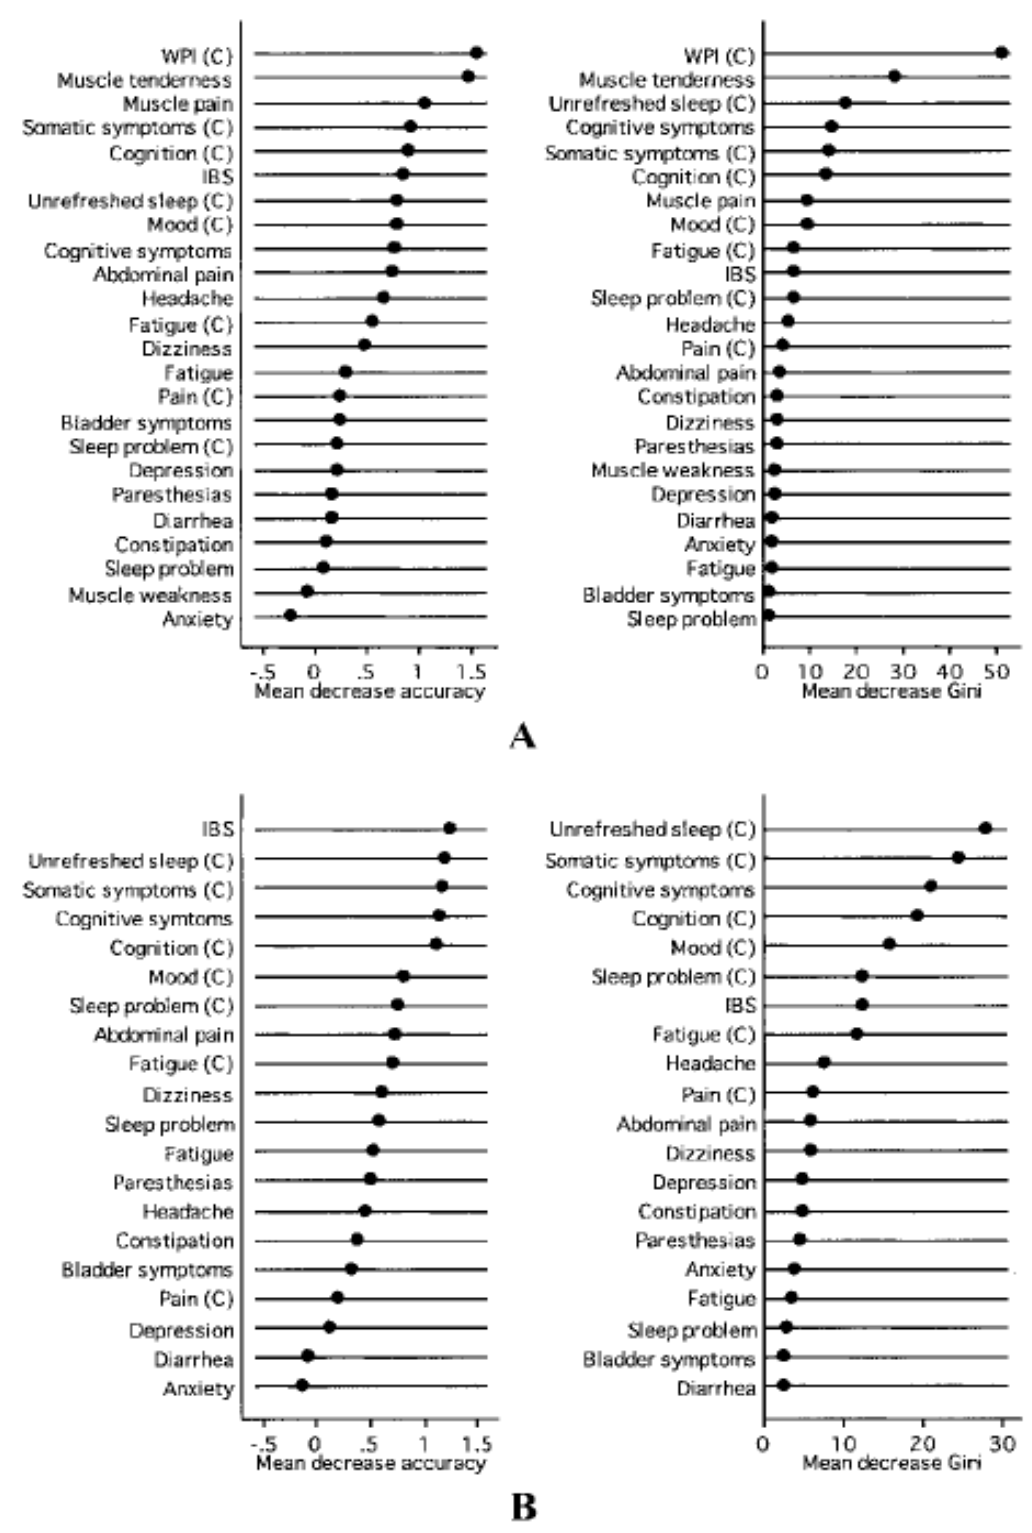
Figure 3. Symptoms of fibromyalgia according to the American College of Rheumatology [3]. ( A ) Variable importance (physician variables) in distinguishing fibromyalgia from controls, including the widespread pain index (WPI) and muscle symptoms. ( B ) Variable importance (physician variables) in distinguishing fibromyalgia from controls, excluding the Regional Pain Scale (WPI) and muscle